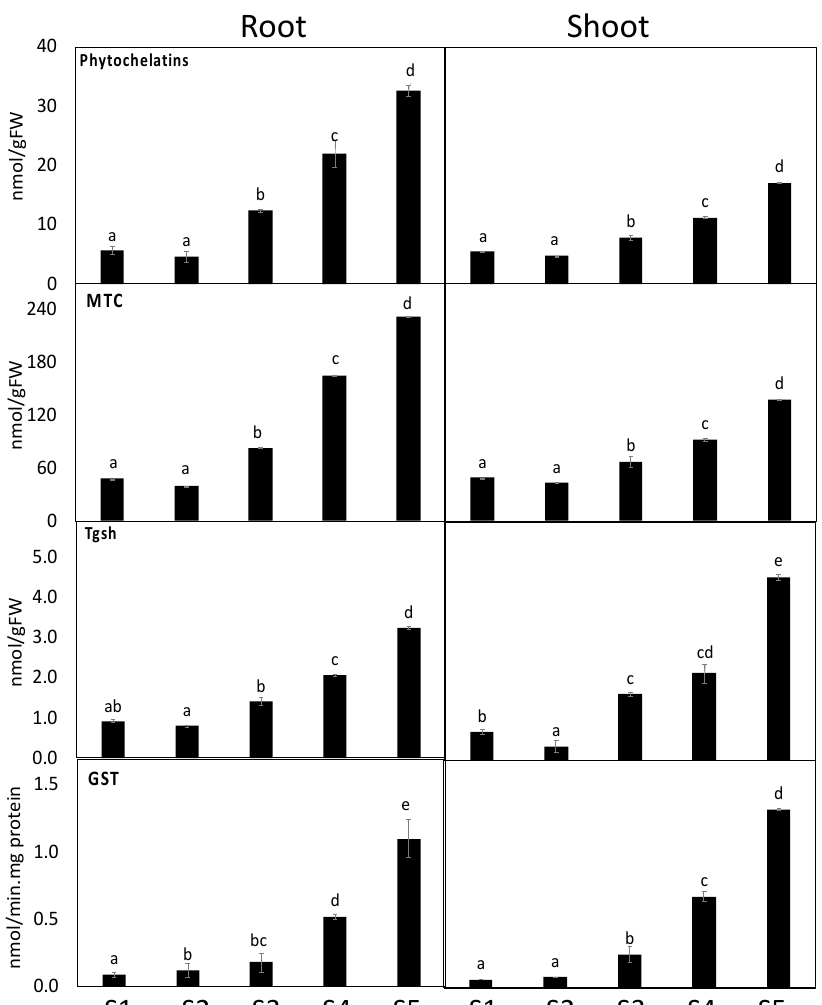
Figure 5. The impact of soil pollution detoxification-related metabolites and enzymes in the shoots and roots of S. portulacastrum grown in different control sites (site 5) and contaminated sites (site 1–4). Data are mean values ± SD ( n = 4). Different letters indicate a statistically significant difference between means of the same plant species at significance level at least ( p ≤ 0.05).